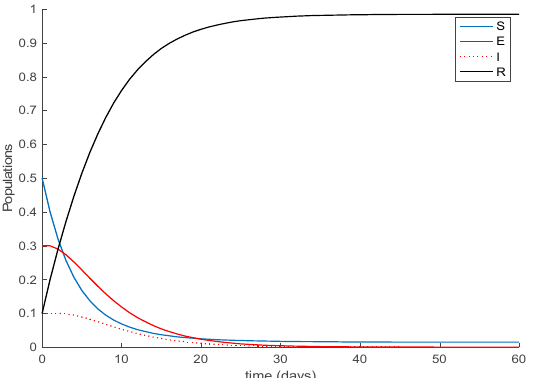
= I = 0 , E and df df